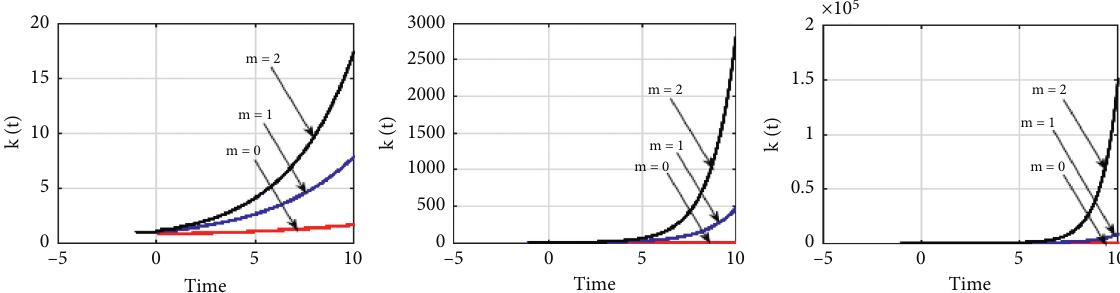
Figure 2: Instability diagrams at τ � 1 when q � 0.25, 0.5, and 0.75 from left to right, respectively ( n � 0).